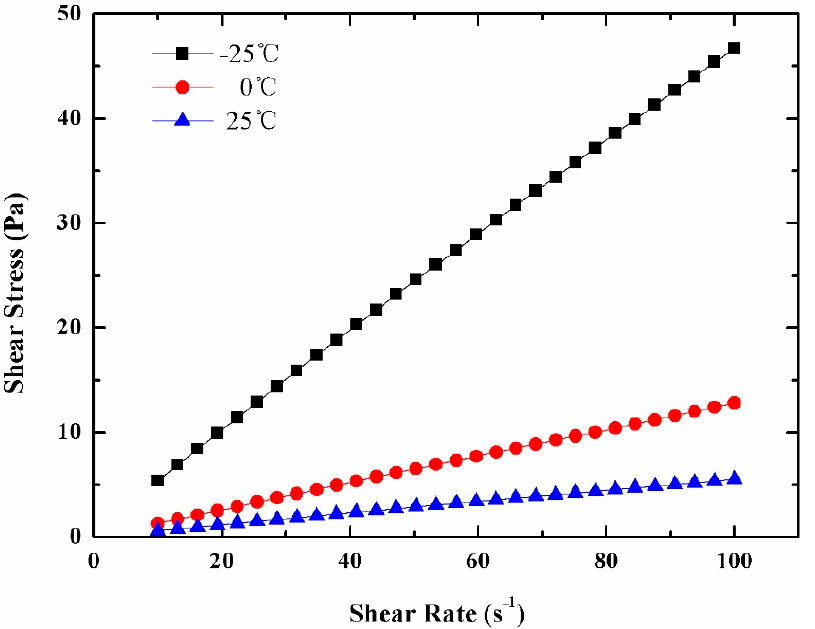
Figure 8. The relationship between shear stress and shear rate of 25 % MPCS at − 25 °C, 0 °C and 25 °C.